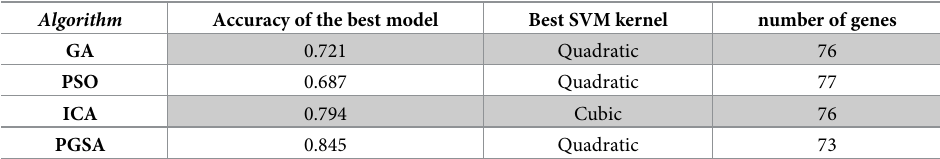
Table 2. The overall accuracy of gene selection algorithms.